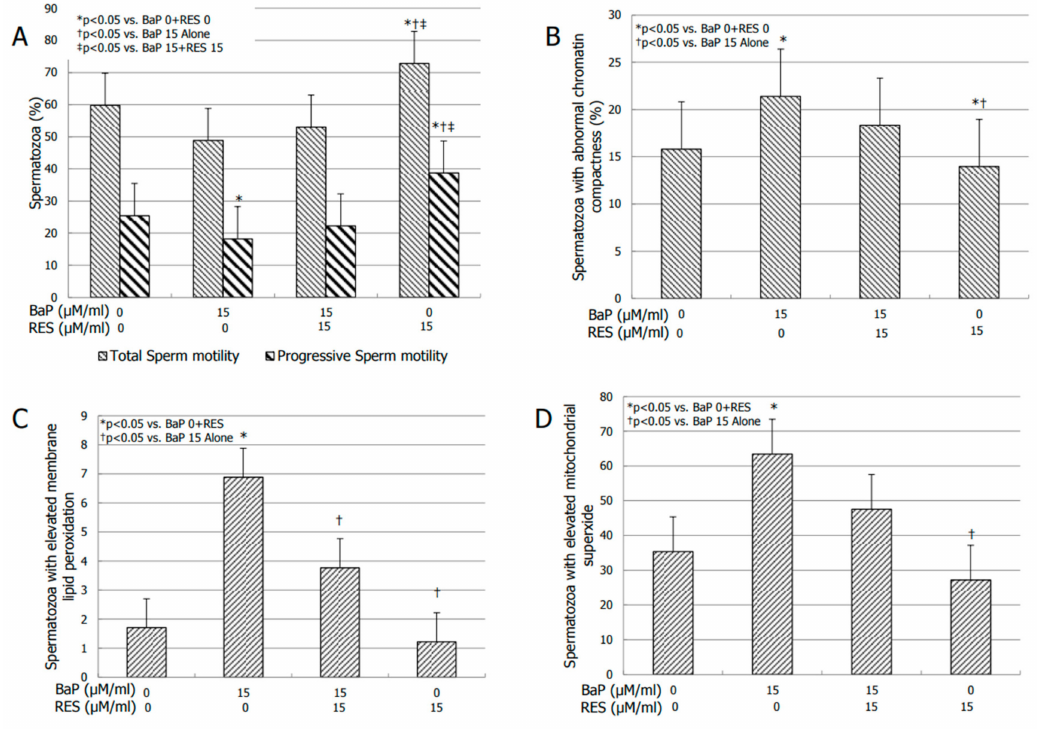
Figure 2. E ff ect of 0, benzo– α –pyrene (BaP) 15, resveratrol (Res) 15 and Res 15 + BaP 15 µ M / mL on total and progressive sperm motility ( A ), degree of chromatin compactness ( B ), lipoperoxidation ( C ), and the amount of mitochondrial superoxide ( D ) after 3 h of incubation on spermatozoa of normozoospermic